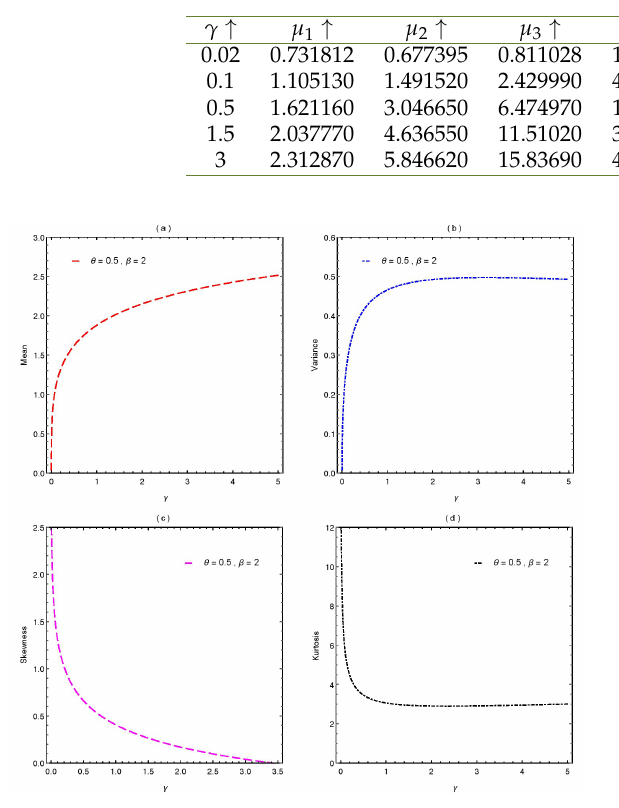
Fig. 3. Plots illustrating the MOPA distribution’s (a) mean, (b) variance, (c) skewness, and (d) kurtosis. q = G − 1 ( p ) . If X represents annual income, L(p) is the pro- portion of total income that accrues to individuals having the 100 p% lowest incomes. If all individuals earn the same income then L ( p ) = p for all p .